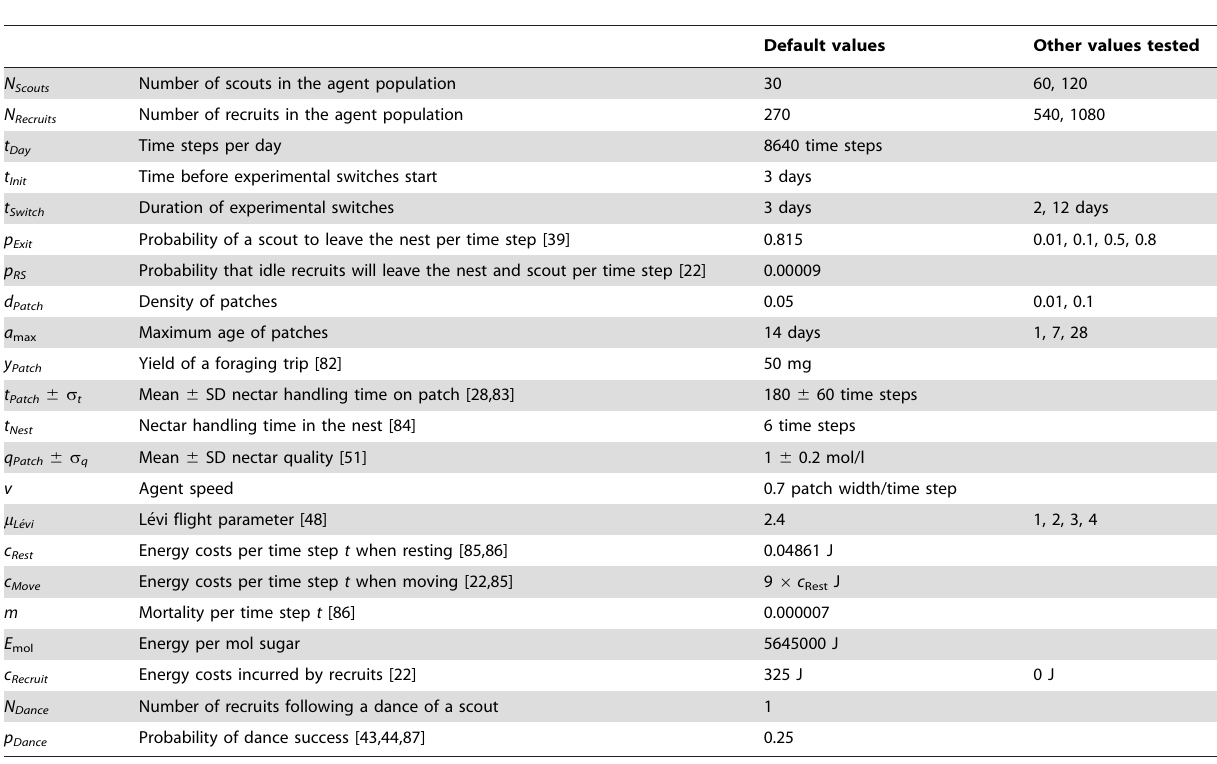
Table 1. Overview of the model parameters and the values used in our simulations.